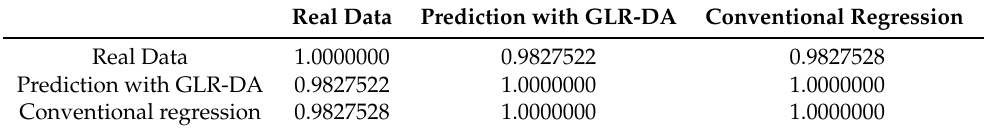
Table 4. Correlation matrix.